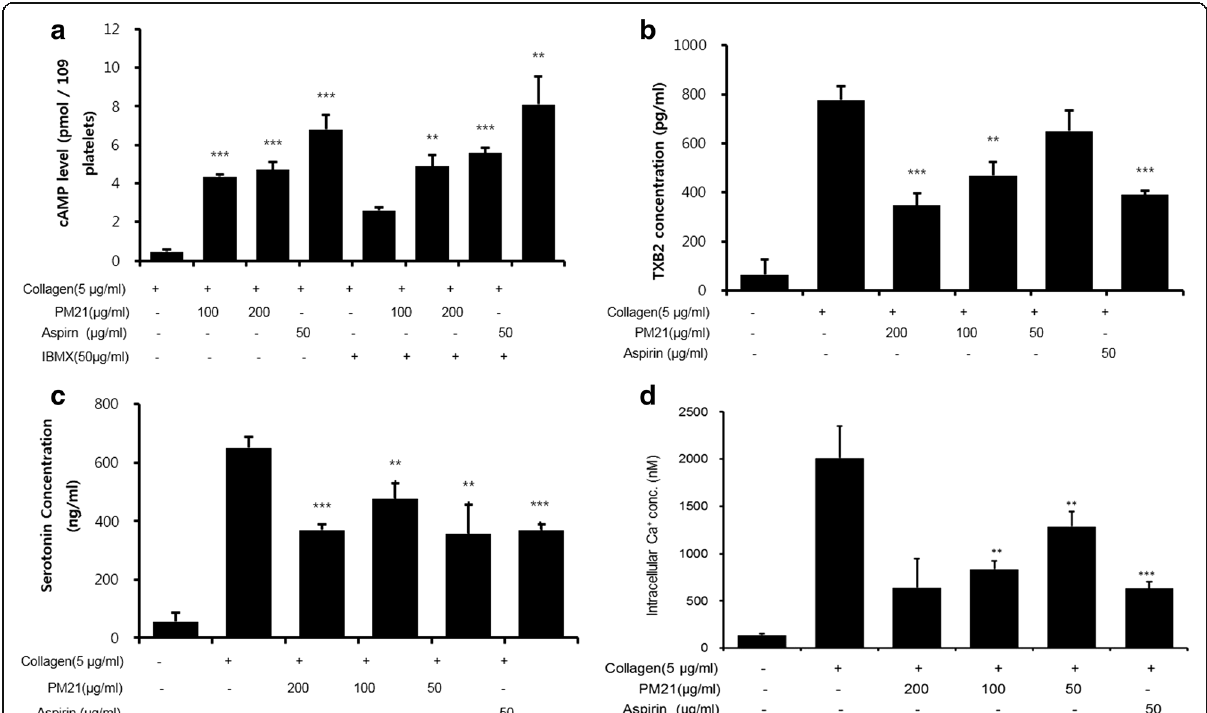
Fig. 4 a Effects of PM 21 on cAMP level. Rat platelets were pre-incubated for 2 min with PM21 (100 and 200 μ g/mL) or aspirin (50 μ g/mL)